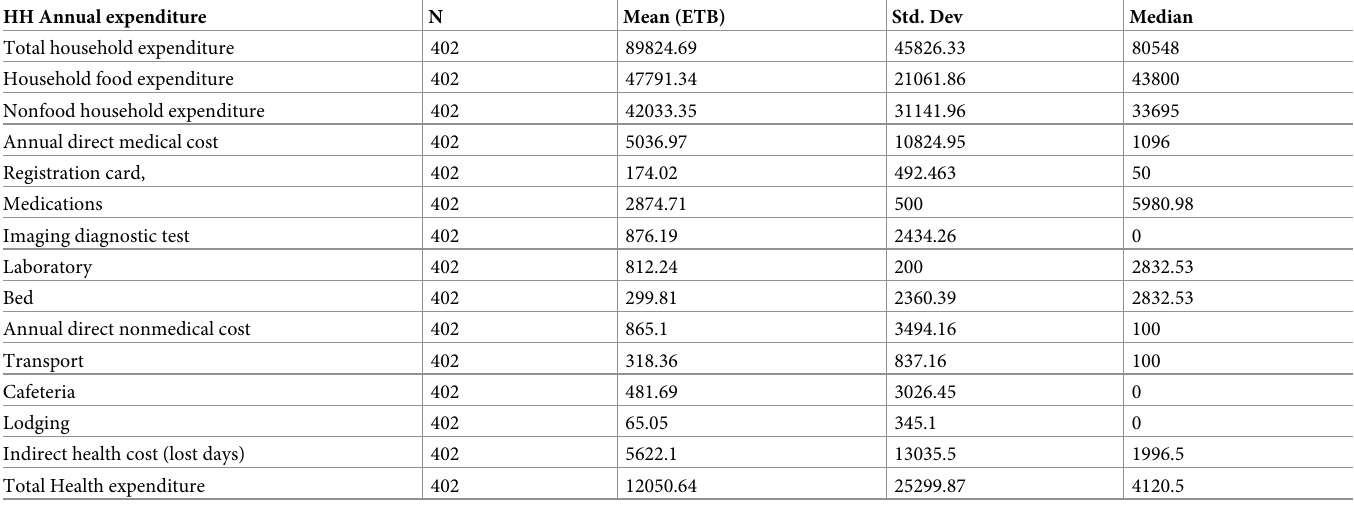
Table 2. Annual total expenditure of households, Debre Tabor town, Ethiopia, 2022.